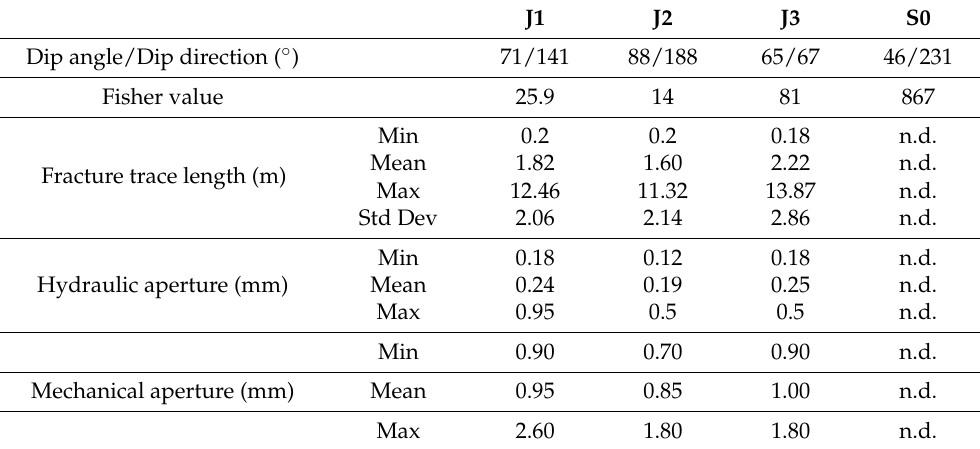
Table 2. Discontinuity set characteristics from the geomechanical survey. n.d. = not detected.